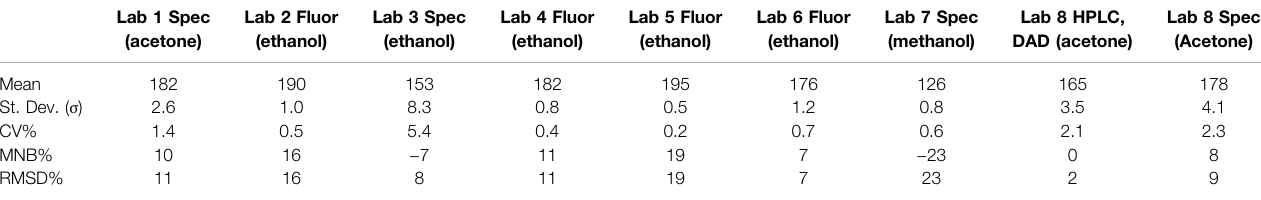
TABLE 3 | Statistical results of the Chl-a standards (µg L − 1 ). For each laboratory, the mean value, the standard deviation ( σ ), and the coef fi cient of variation (CV%) were derivedfromthethreereplicates.TheRMSD%andtheMNB%werederivedheremathematicallyinrelationtothemeanconcentrationmeasuredbyHPLC,whichhasan error of about 2 – 3% (Canuti et al.,